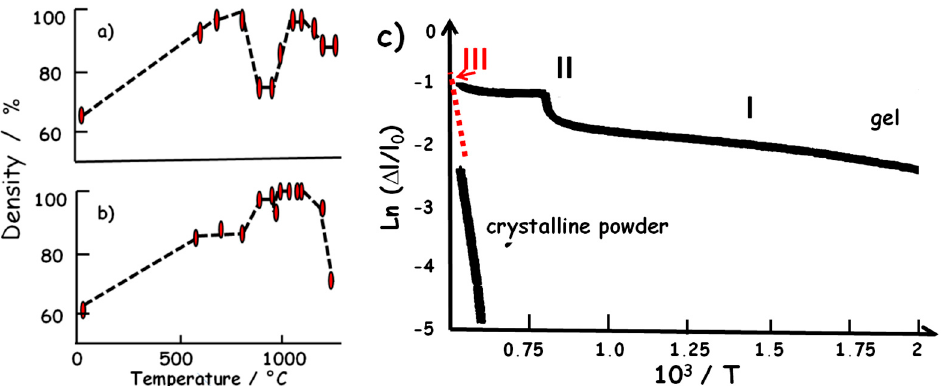
Figure 6. Density (in % of the theoretical density deduced from the unit-cell parameter measured by XRD) as a function of the firing temperature and of the ‘green state’ pressure sintering of Nasicon (x = 2) pellets ( a ), high compaction obtained for 10 h; ( b ), medium compaction for 2 min (after [14]); ( c ), comparison of the densification expressed in logarithmic ratio of the thermal expansion ( ∆ l / l 0 ) versus 1000 / T (T in K) for the compacted mullite gel (regime I) and the standard (micronic) commercial powder (Baikowsky, France). II, nucleation-densification; III, standard regime, (after [236]).